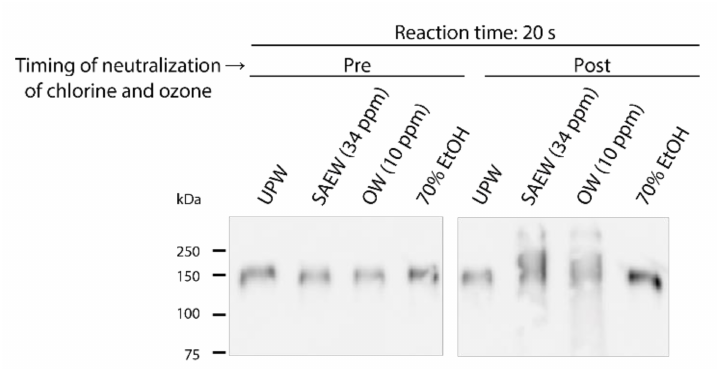
Figure 4. Impact of test solutions on the SARS-CoV-2 S protein. Images of the results of Western blotting analysis targeting the SARS-CoV-2 S protein S1 subunit are shown. Pre indicates that Na 2 S 2 O 3 was added to each test solution before mixing with the recombinant S protein S1 subunit; Post indicates that Na 2 S 2 O 3 was added 20 s after mixing with the S1 subunit. UPW, ultra-pure water; SAEW, slightly acidic electrolyzed water; OW, ozonated water; EtOH,